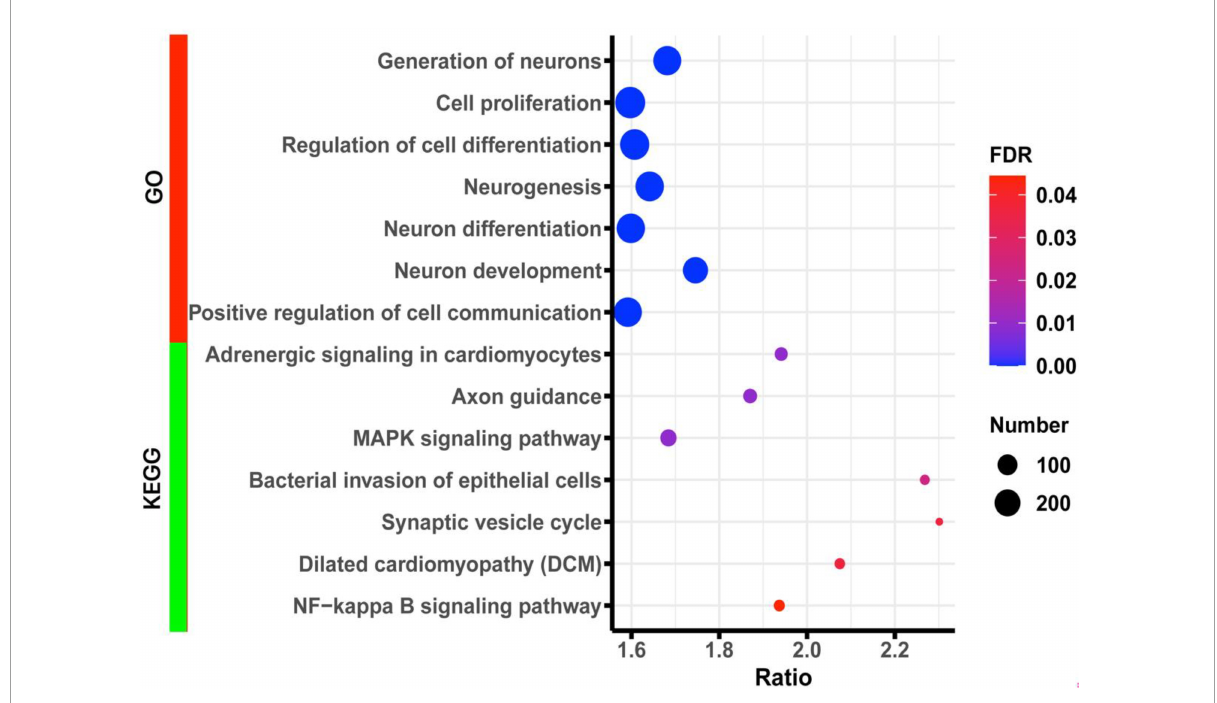
FIGURE5 Bubble charts of the enrichment results of GO and KEGG terms for the Lpl correlated genes. The x -axis represents an enriched ratio, and the y -axis represents enriched terms. The size of the dots represents the number of genes, and the color indicates the FDR value. An enriched ratio is defined as the number of observed divided by the number of expected genes from the annotation category in the gene